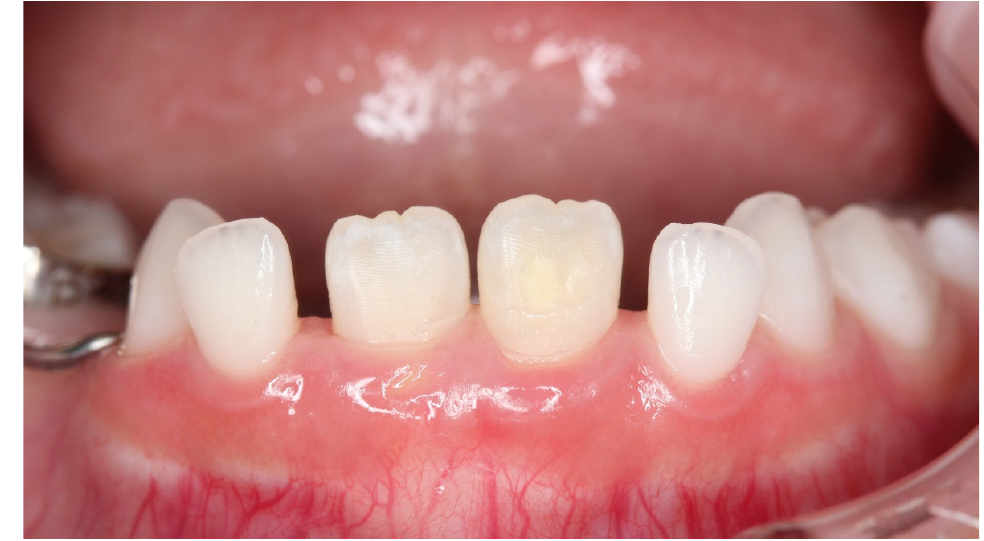
Figure 11. Case 4: Intraoral photograph after seven-times treatment. Table 4. In Case 4, the cloudiness and brown areas from the pre-treatment (before applications) and post-treatment (after seven applications) images were measured as pixels by digital image analysis. The analysis was performed three times, and the mean and standard deviations of the measure- ments were calculated (mean ± SD). The significance of the differences in areas before and after treatment was evaluated with p- values by t- test.